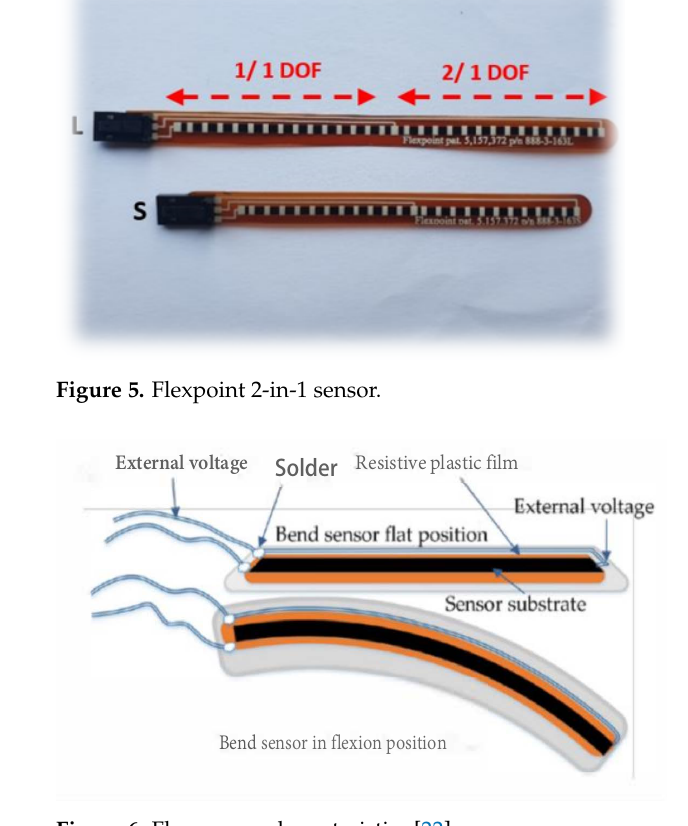
Figure 6. Flex sensor characteristics [22].